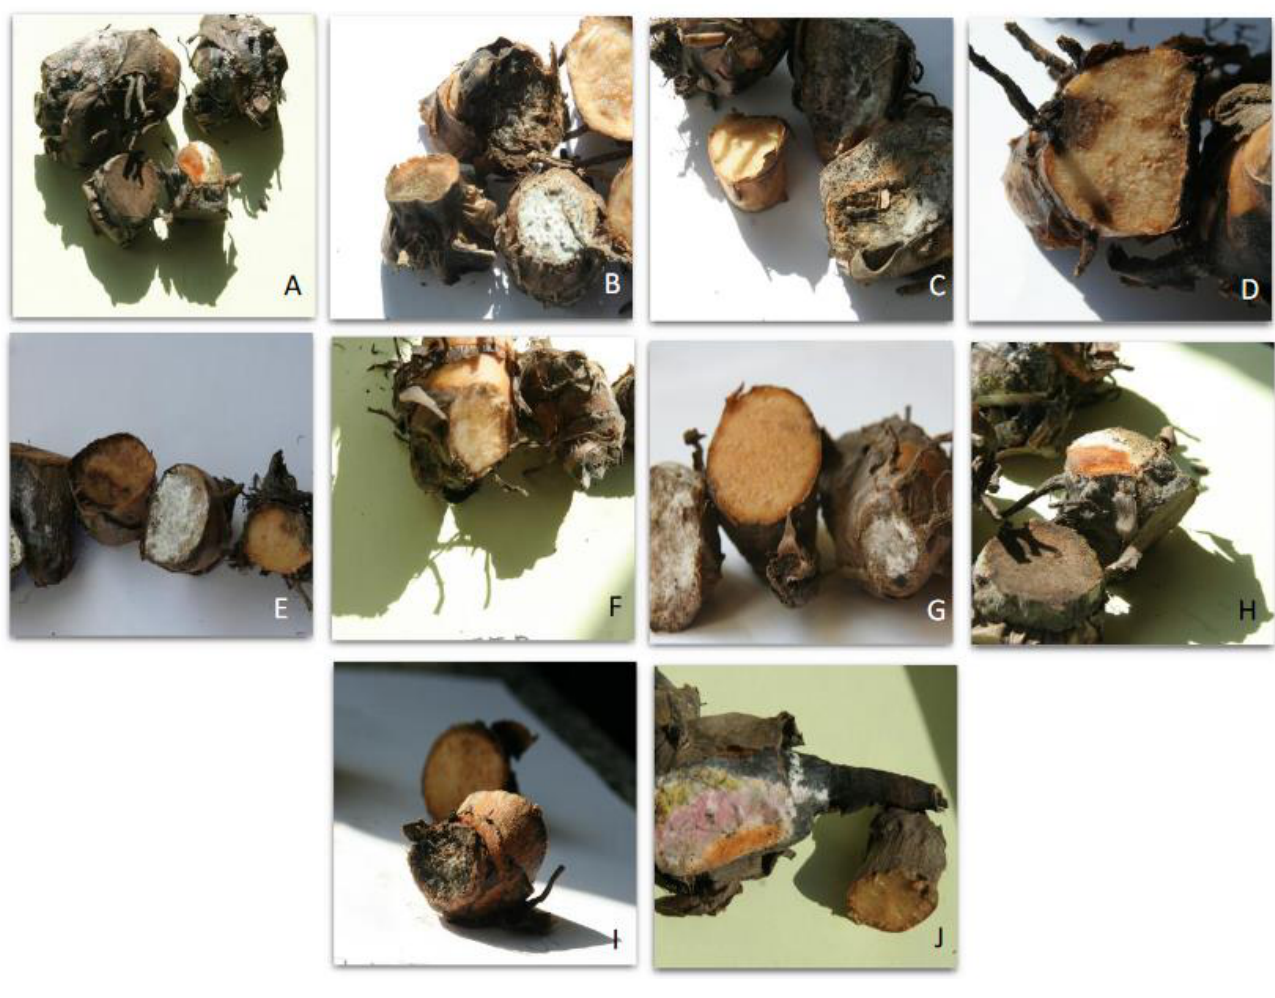
Figure 6. Disease symptoms on rhizome of different canna varieties: ( A )—‘Aida’, ( B )—‘America’, ( C )—‘Botanica’, ( D )—‘Cherry Red’, ( E )—‘La Boheme’, ( F )—‘Lucifer’, ( G )—‘Picasso’, ( H )—‘President’, ( I )—‘Robert Kemp’, ( J )—‘Wyoming’.